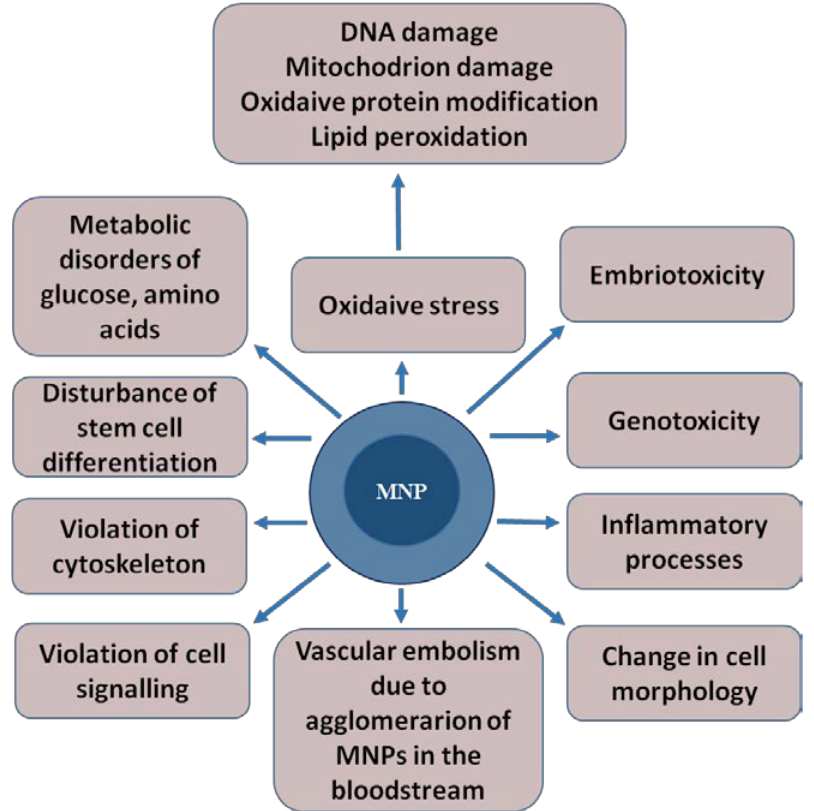
Figure 2. The toxic effects that magnetic nanoparticles can cause in a living organism. The magnetic core of the nanoparticle is shown in dark blue, and shell is represented in light blue.